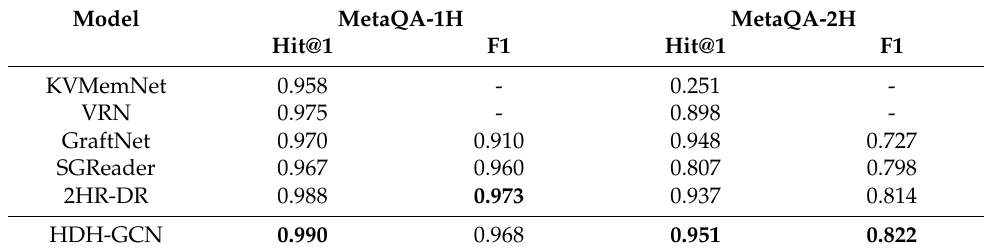
Table 4. Results of Hit@1 and F1 on MetaQA-1H and